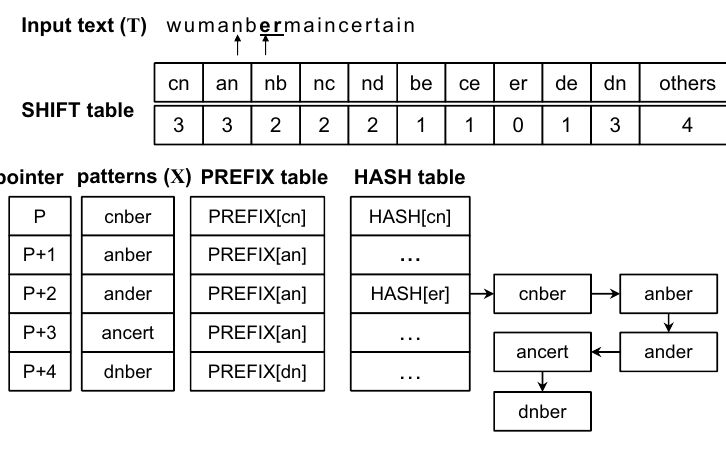
Figure 2. Wu–Manber multiple pattern-matching